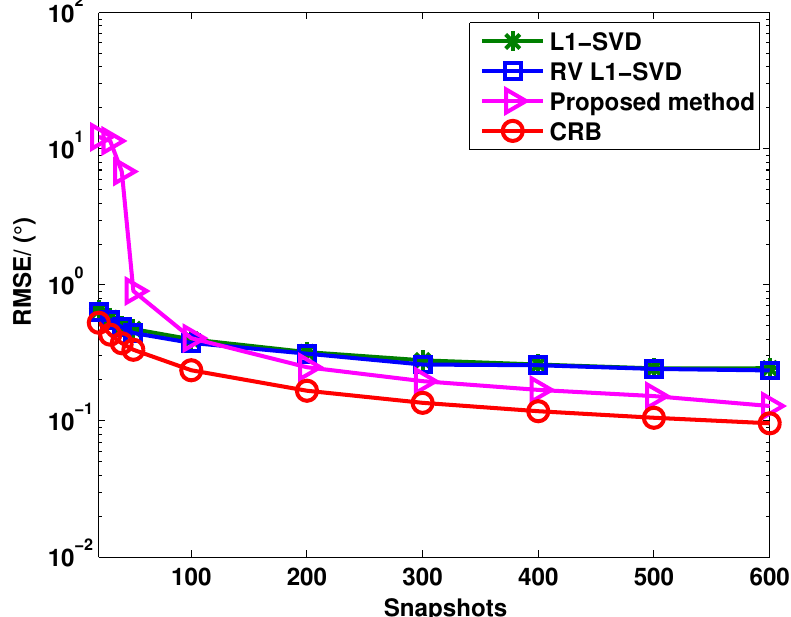
Figure 3. RMSE of l -SVD, RV l -SVD and the proposed method for uncorrelated targets 1 1 when the snapshots number varies from 20 to